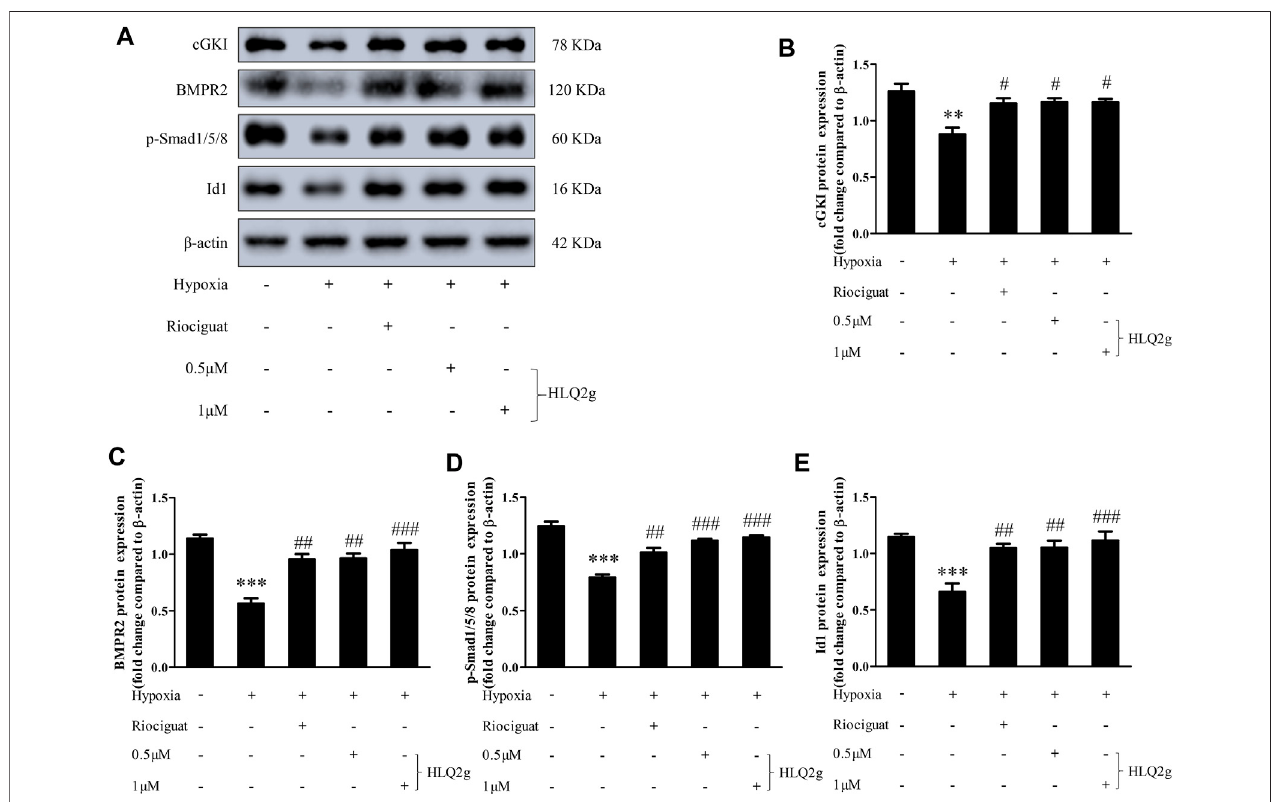
FIGURE 6 | HLQ2g can upregulate cGKI expression and BMP signaling pathway in Hypoxia-induced HPASMCs. (A) : The protein expression of cGKI, BMPR2, p-Smad1/5/8,andId1inHPASMCs determined byWesternblot.Riociguat (1 μ M). (B – E) :QuantitativeanalysisresultsofgraphA.Dataexpressed asmean ± SD, n (cid:1) 3. Vs. the control, ** p < 0.01, *** p < 0.001; vs. the Hypoxia group, # p < 0.05, ## p < 0.01, ### p <